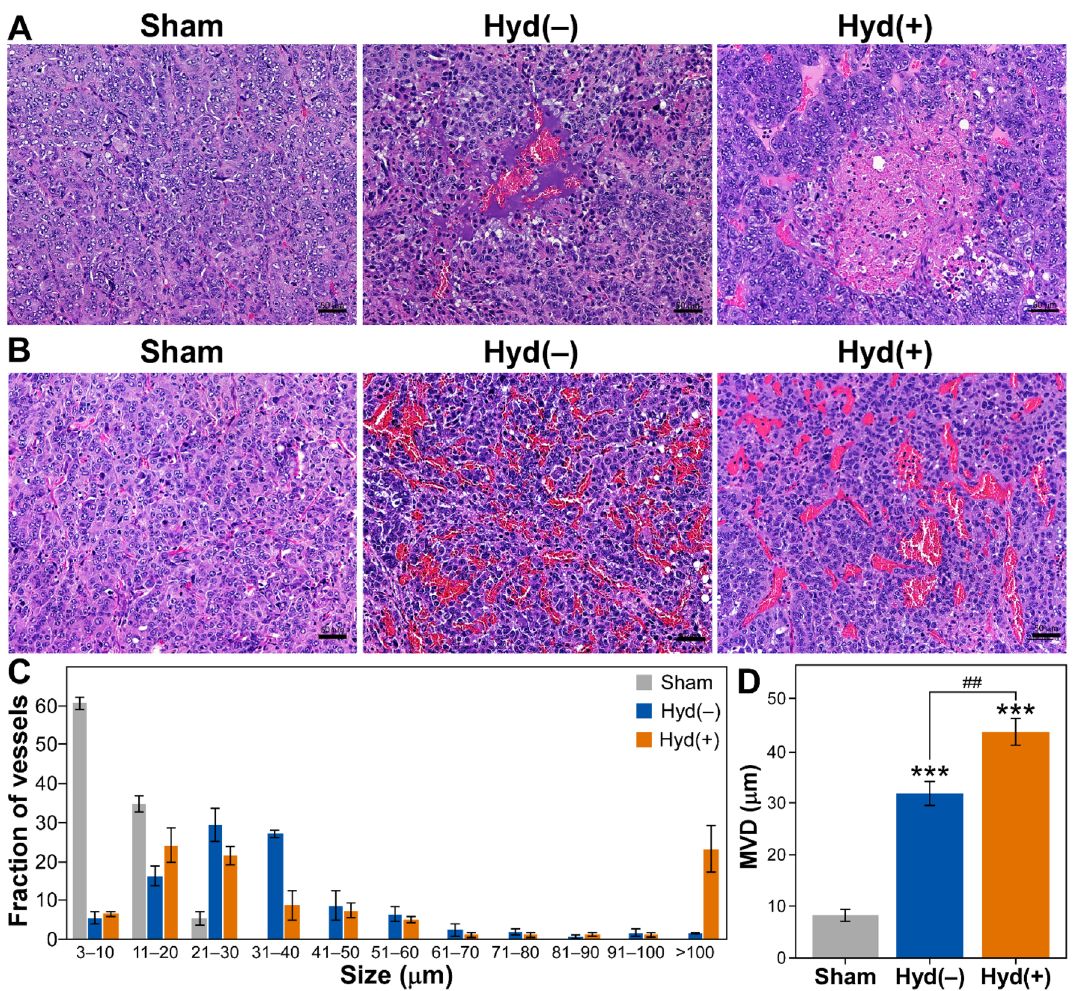
Figure 6. Histological examination of HCC. H&E-stained images of tumor samples showing hemorrhagic pools ( A ) and tumor vessels ( B ) in the sham-treated (Sham) or ultrasound-treated groups with [Hyd(+)] or without [Hyd(−)] hydralazine. Scale bar = 50 μm. In comparison to the sham group, there were obvious regions of hemorrhage following therapy, especially in tumors receiving hydralazine and ultrasound. ( C ) Histogram showing the distribution of tumor blood vessels. ( D ) Histogram showing the mean vessel diameter (MVD) of the tumor vessels. Difference in MVD between Sham vs. Hyd(−) (*** p ≤ 0.001) and Sham vs. Hyd(+) (*** p ≤ 0.001), and between Hyd(−) vs. Hyd(+) ( ## p ≤ 0.01) is statistically